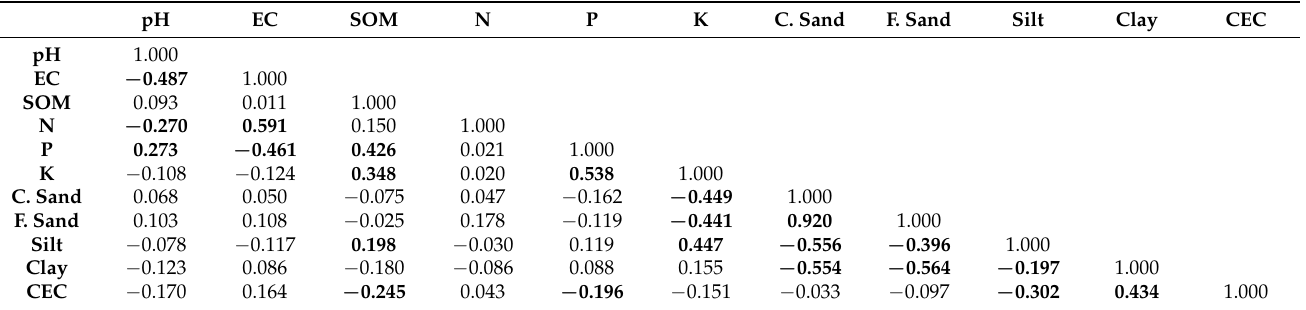
Table 6. Spearman correlation matrix of soil physical–chemical parameters in the 0–20 cm layer.